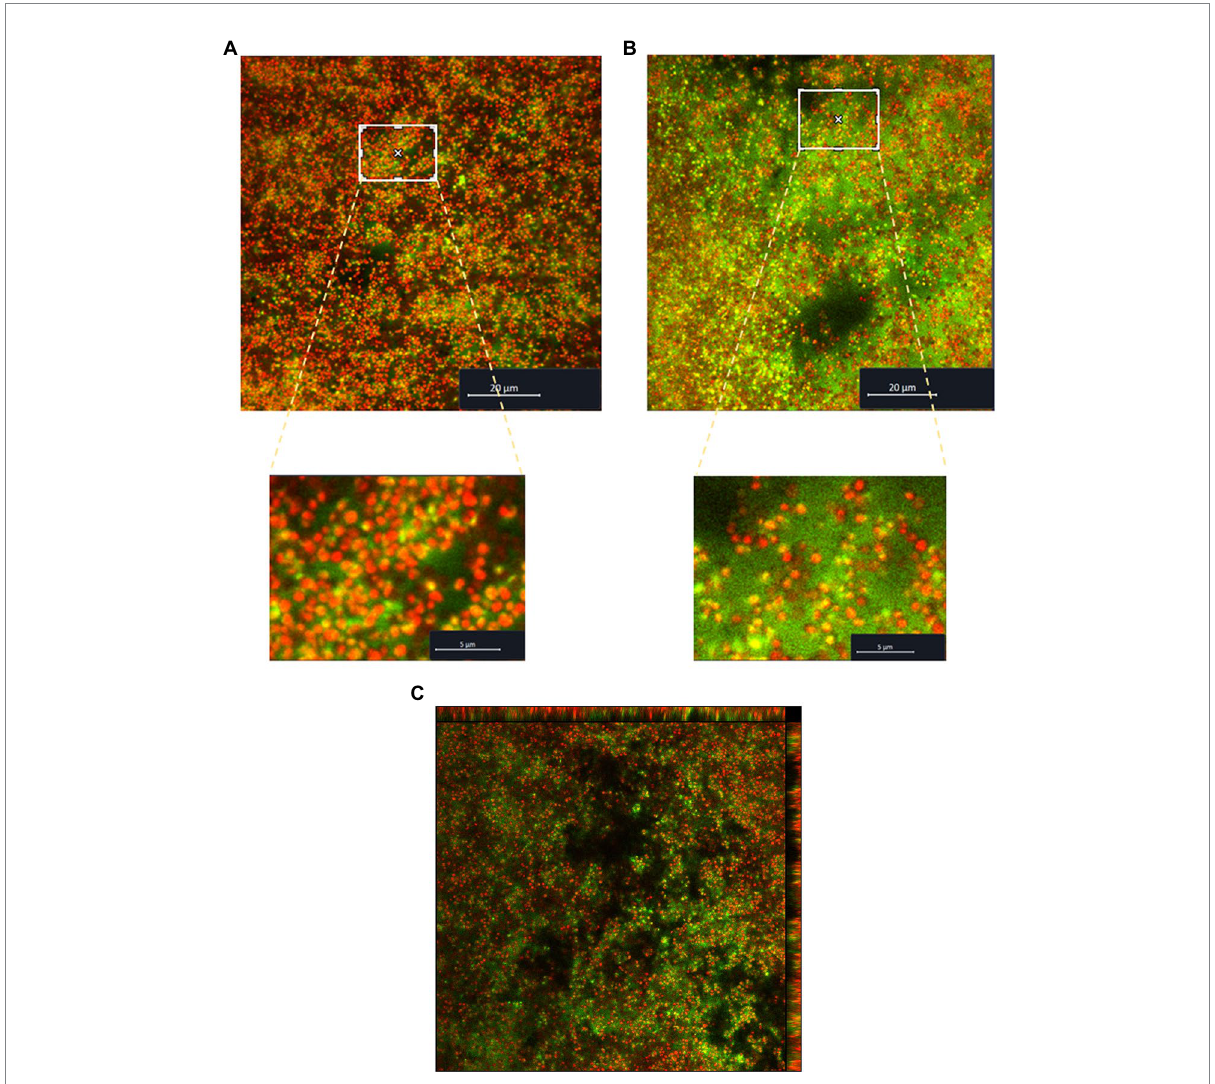
FIGURE 3 Visualization of the biofilm structure of S. saccharolyticus assessed by CLSM. (A) Biofilm structure formed by the strain 13 T0028 in BHCY supplemented with 1% glucose and 1% NaCl, visualized by CLSM. (B) Biofilm structure formed by strain 13 T0028 in BHCY without supplements. Viable cells were stained in red, and eDNA in green; dead cells appear in yellow (co-localization of red and green color). For better visualization, magnifications of selected regions are shown as zoom-in figures in A and B . (C) 3D view of the biofilm of S. saccharolyticus , grown in BHCY without